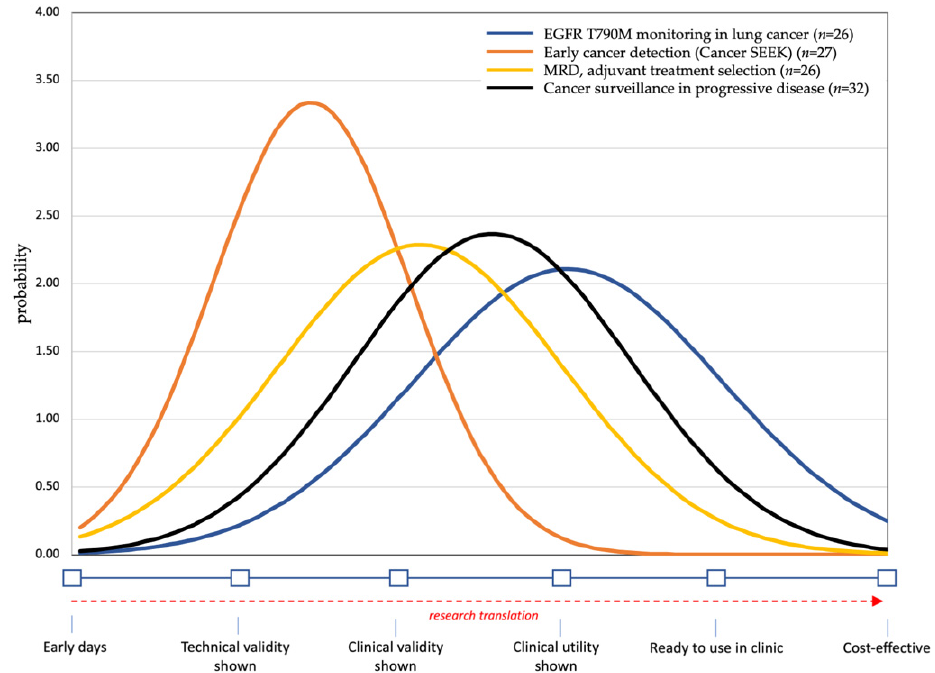
Figure 5. Density plots presenting the translational stage of the 4 ctDNA applications.